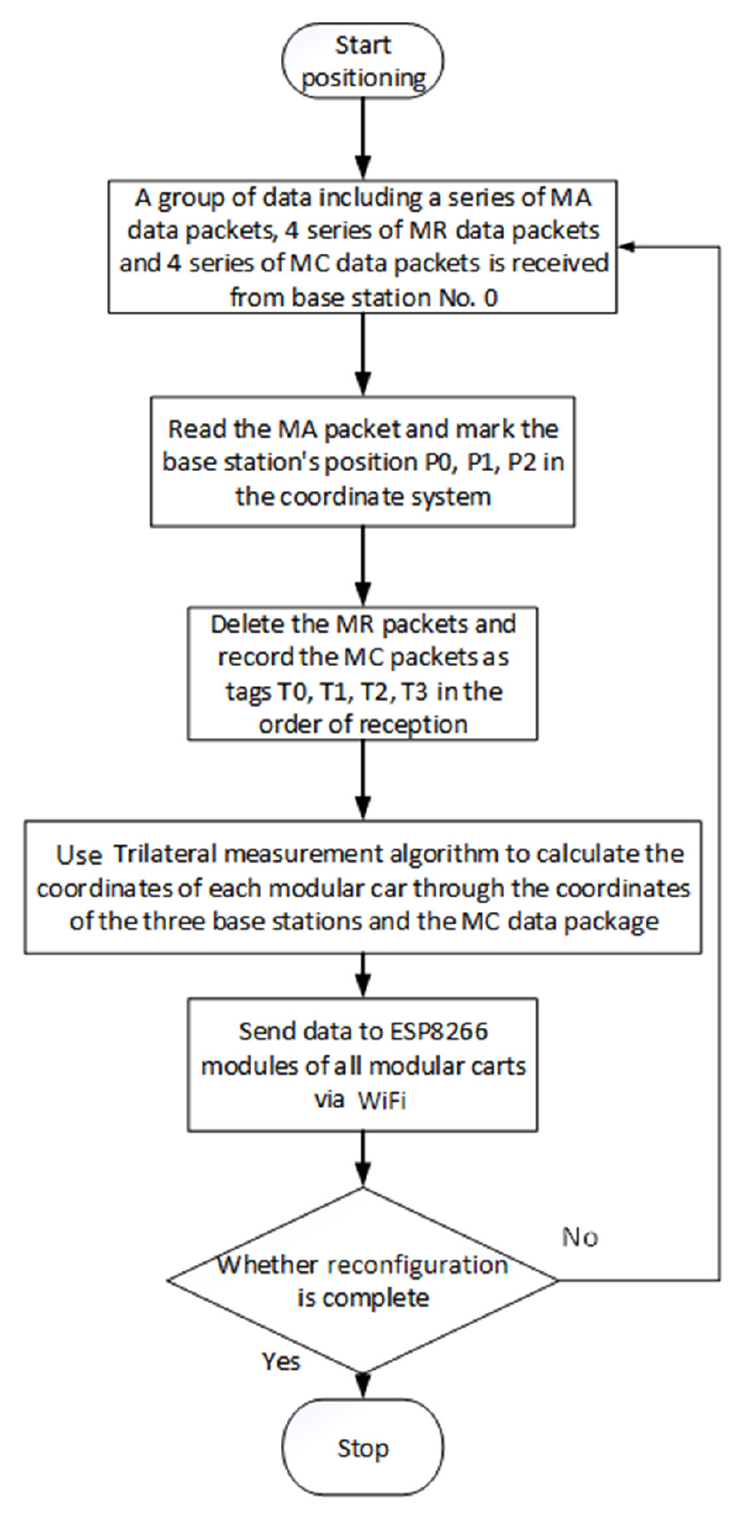
Figure 14. Flow chart of UWB location algorithm.